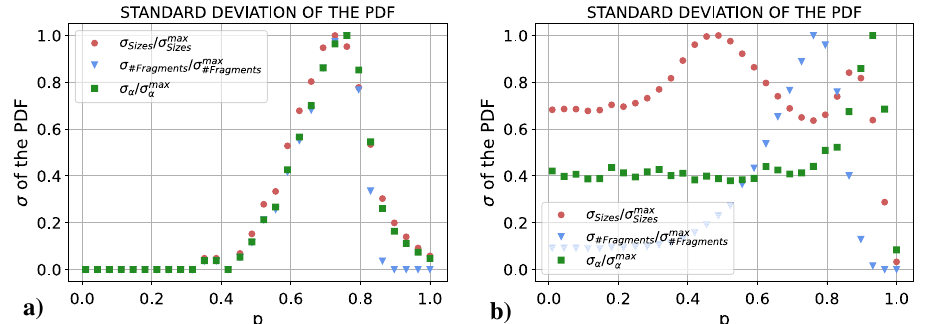
Figure 4. Variances of the distributions of α , the size and the number of the fragments (divided by their maximum value) for each value of p in the ( a ) RD and ( b ) UI